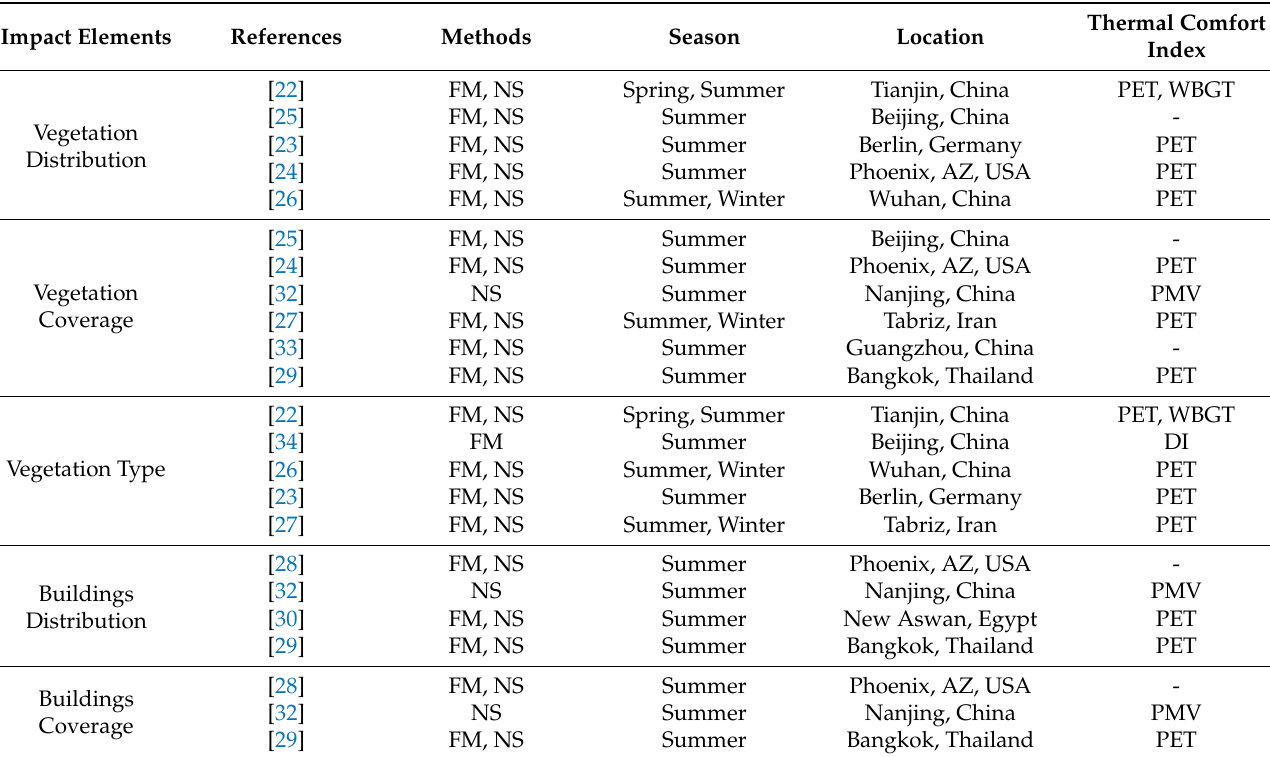
Table 1. References of residential outdoor microclimate research about space composition in recent